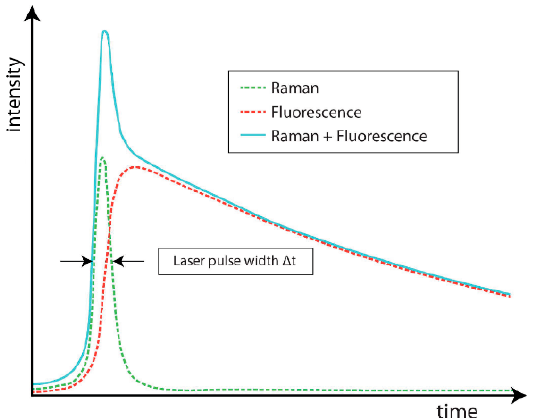
Figure 4. Raman and fluorescence signal time profiles [26]. Note that Raman intensity can be even much lower than the fluorescence one.